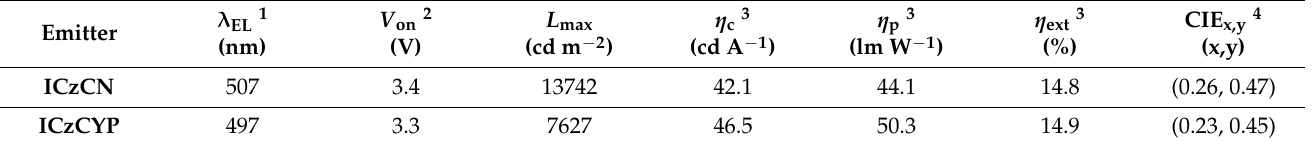
Figure 4. ( a ) Energy level diagram of a TADF-OLEDs device with ICzCN and ICzCYP as an emitter. ( b ) EL spectra of 12 wt% ICzCN and ICzCYP devices at 10 mA cm − 2 ( c ) Current density-voltage- luminance ( J - V - L ) curves of TADF-OLEDs device with 12 wt% ICzCN and ICzCYP applied as emitter ( d ) External quantum efficiency versus luminance ( η ext ) of devices. Table 3. EL performance data of 12 wt% ICzCN and ICzCYP devices.